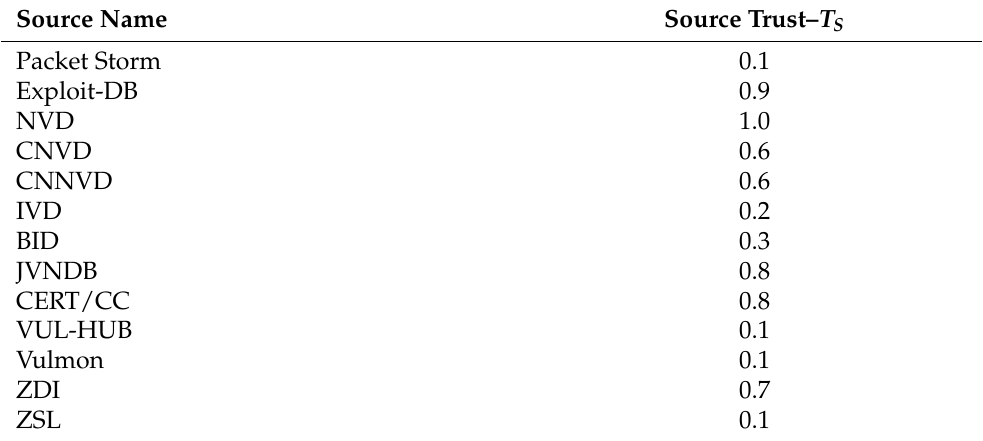
Table 2. Source trust of all sources